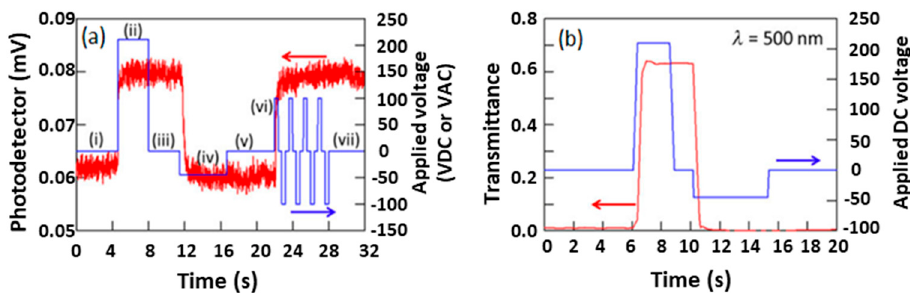
Figure 6. Response time of PSCLCs with 30 µ m thickness. An optical setup employing a photodetector connected to an oscilloscope measured the relative intensity of light transmission as the PSCLC was subjected to ( a ) at ( i ) 0 V, ( ii ) 210 V DC, ( iii ) 0 V, ( iv ) − 45 V DC, ( v ) 0 V, ( vi ) 100 V AC with 1 kHz, and ( vii ) 0 V over various time intervals. ( b ) The transmission of unpolarized light at 500 nm to measure the response time is illustrated. Adapted from ref. [49].